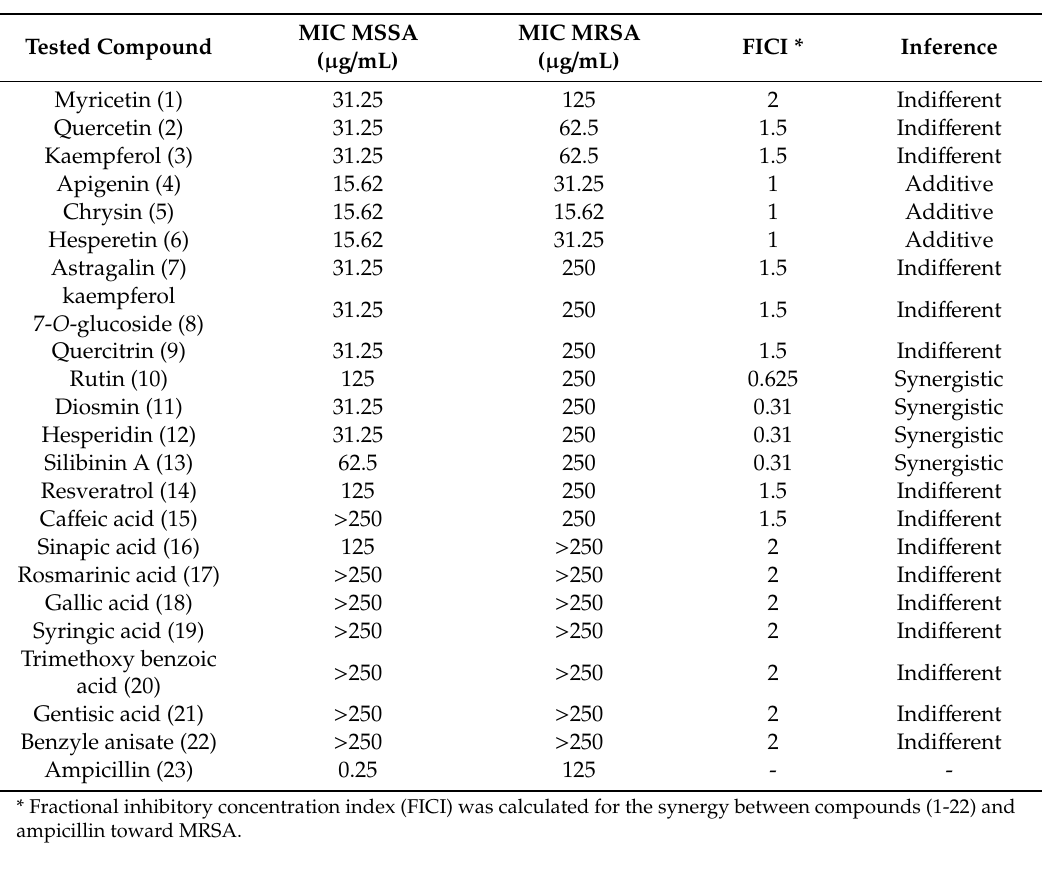
Figure 5. Binding mode of chrysin (5) inside PBP2a’s active site ( A and B ). In another site on this interesting protein (i.e. PBP2a) and 60 Å away from the catalytic active site, the controller allosteric site is located (Figure 6A) [12]. This binding cavity in contrast to the active site is more exposed, and hence, glycosylated flavonoids can achieve good interaction with such an opened binding site. Docking results revealed that flavonoids attached to two sugar moieties (compounds 10–12), in addition to the flavonolignan silibinin A (13), showed interesting binding energy scores ranging from − 8.8 to − 10.3 kcal/mol. Moreover, these compounds displayed high stability inside the allosteric binding site during the MDS (e.g., hesperidin (12), Figure 6C and Figure S2), where they interacted with several amino acid residues, including the reported ones [12], through multiple strong H-bonds thanks to the polyhydroxyl groups in these compounds. In regard to the non-glycosylated flavonoids and the other phenolic derivatives, they could not get binding scores higher than − 7.2 kcal/mol, and most of them did not achieve stable binding interactions inside the allosteric site during MDS (average RMSD > 6 Å). These findings reflect well on the anti-MRSA synergy study, where the glycosylated flavonoids significantly reduced the MIC values of ampicillin from 8- to 16-fold (Table 2). Such compounds most probably act in the same way as ceftaroline (24), where they bind to the allosteric receptor, which in turn induces a series of conformational changes ended by opening the active site to receive one molecule of ampicillin (Figure 7) [12].